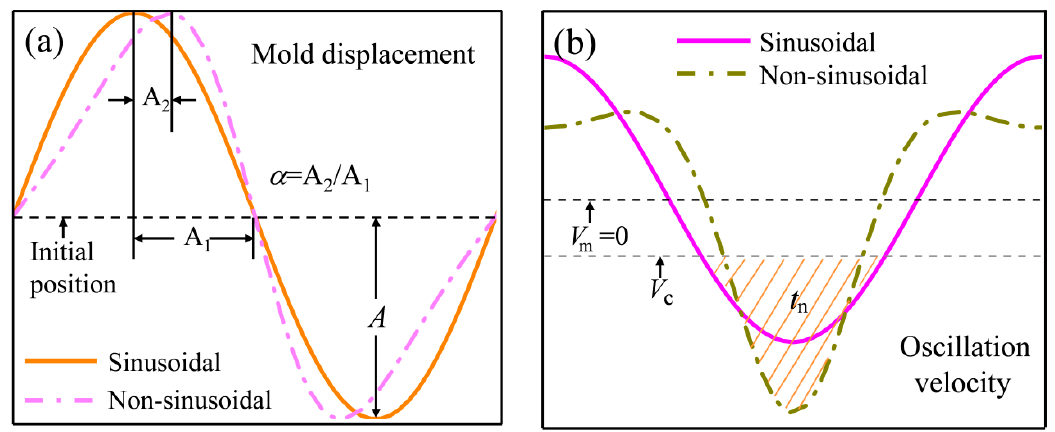
Figure 1. Schematic of sinusoidal and nonsinusoidal oscillation waveform curves: ( a ) mold displacement and ( b ) mold oscillation velocity.